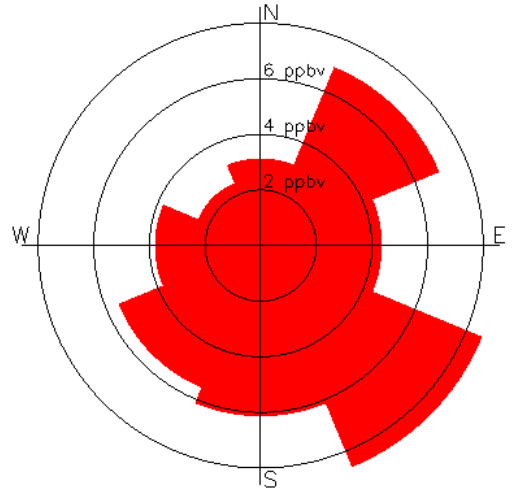
Fig. 7. Average surface NO 2 mixing ratio during CINDI as a function of wind direction. Included are data between 06:00 and 18:00UTC and with wind speed exceeding 1.5ms − 1